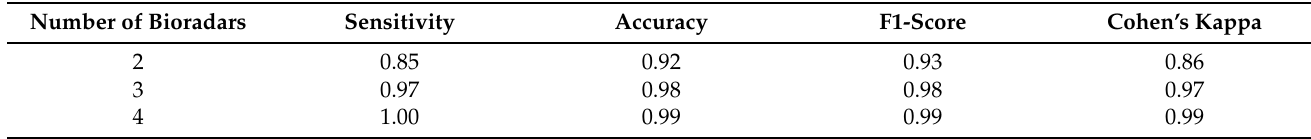
Table 2. Average classification scores.